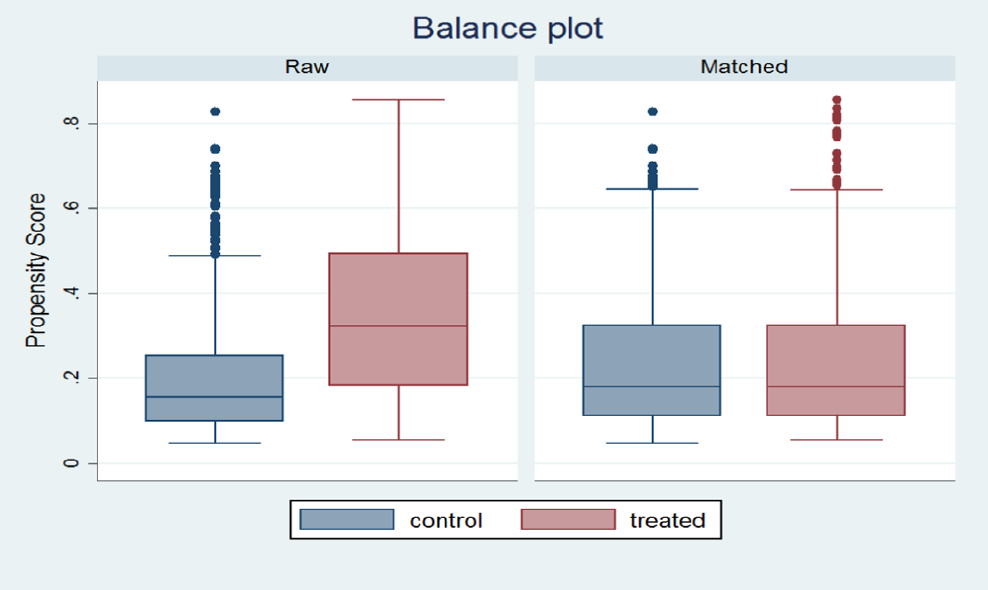
Figure A2. Box balance for housing insecurity